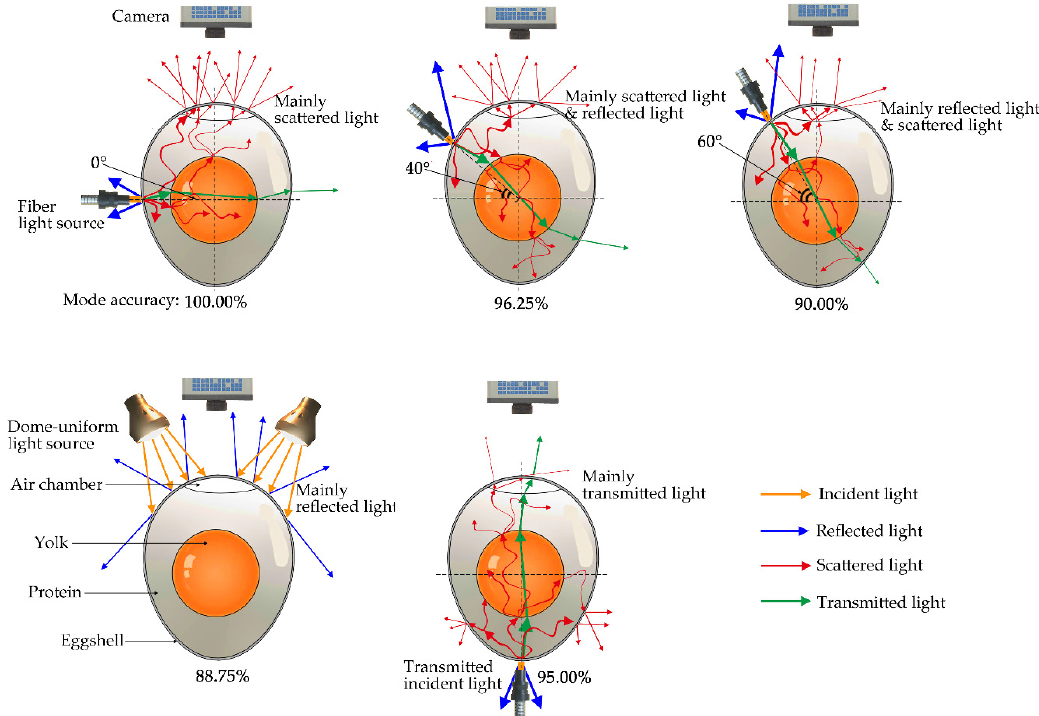
Figure 13. Light propagation inside an egg.